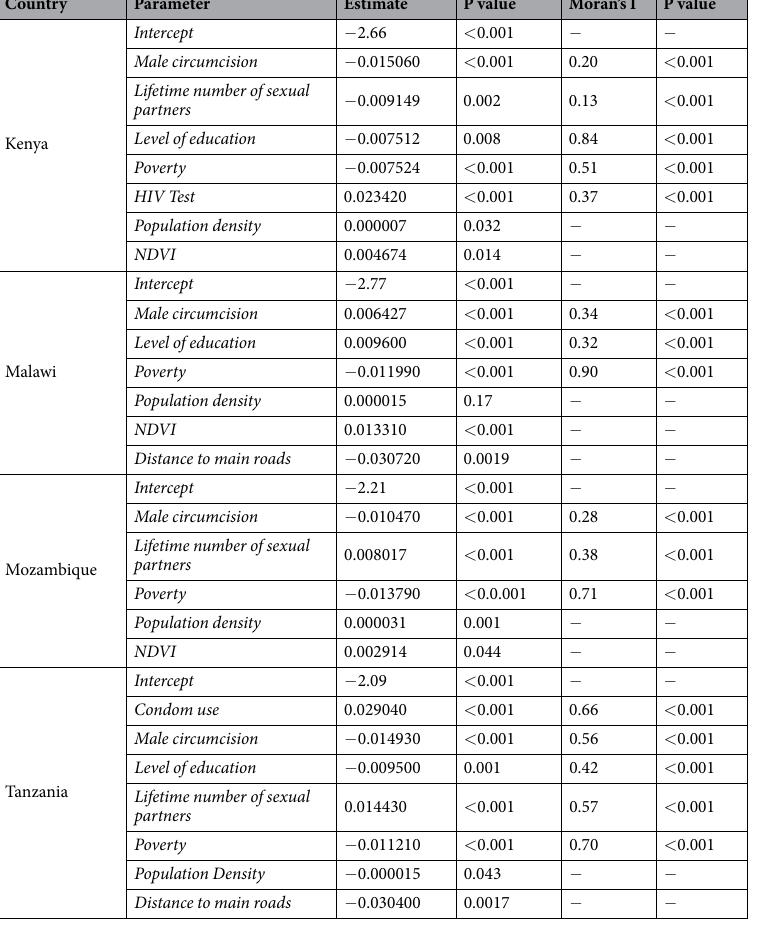
Table 1. Variables in the final logistic regression model for each Model validation. (RMSE = 6.49), Kenya (RMSE = 8.15), and Malawi (RMSE = 9.09). Moran’s Index identified significant spa-